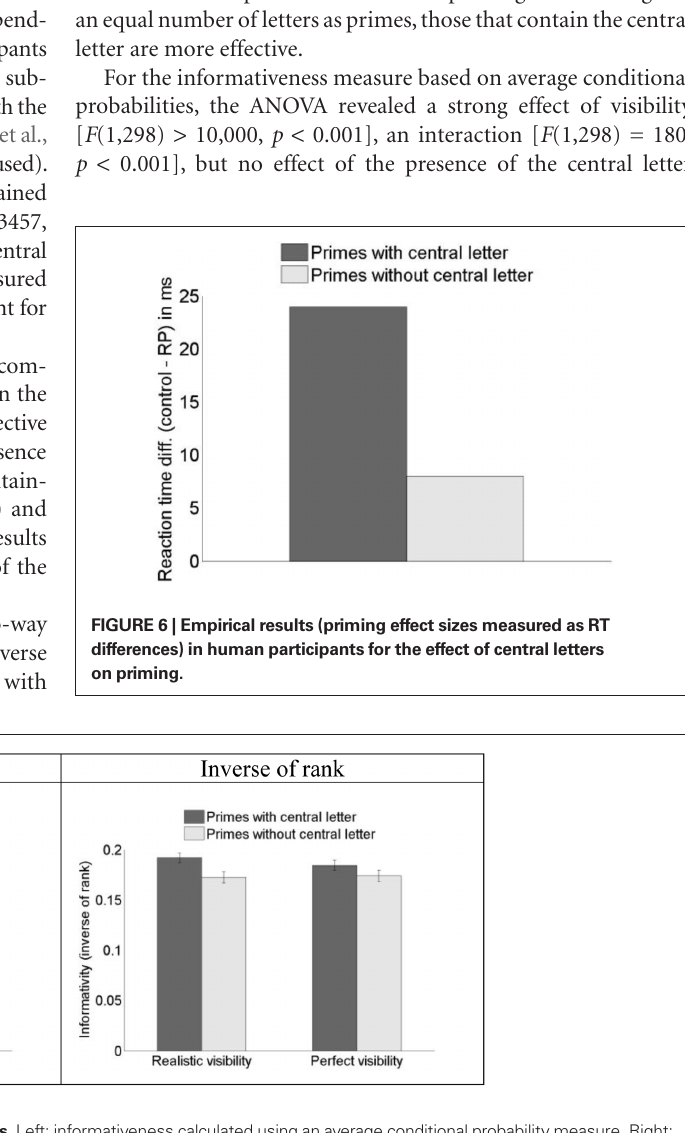
Figure 7 | effect of central letter on priming in bigram-based analyses. Left: informativeness calculated using an average conditional probability measure. Right: informativeness calculated using the inverse of within-word